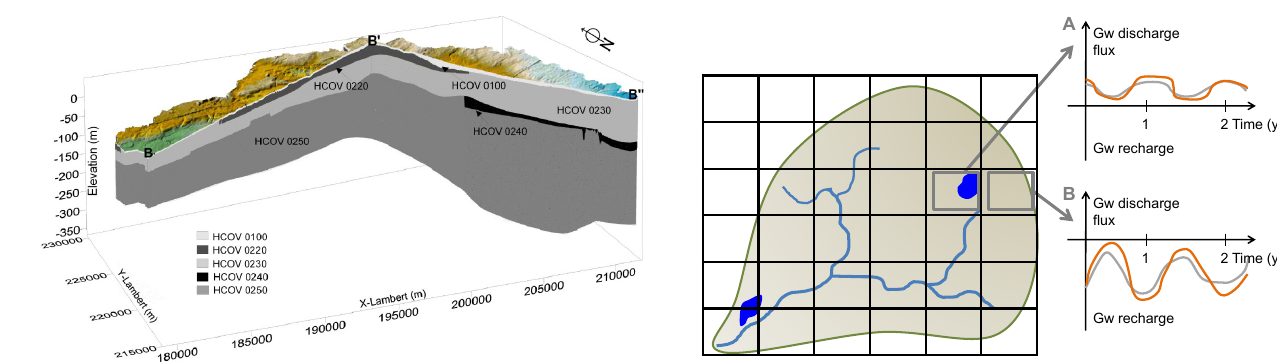
Fig. 3. Cross-section along profile B-B’-B” presented in Fig. 2 showing the different Tertiary formations. The HCOV aquifer codes are given in Table 1.